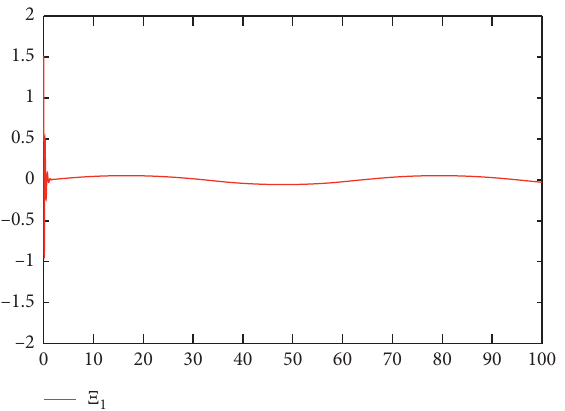
Figure 2: The response of the tracking error Ξ